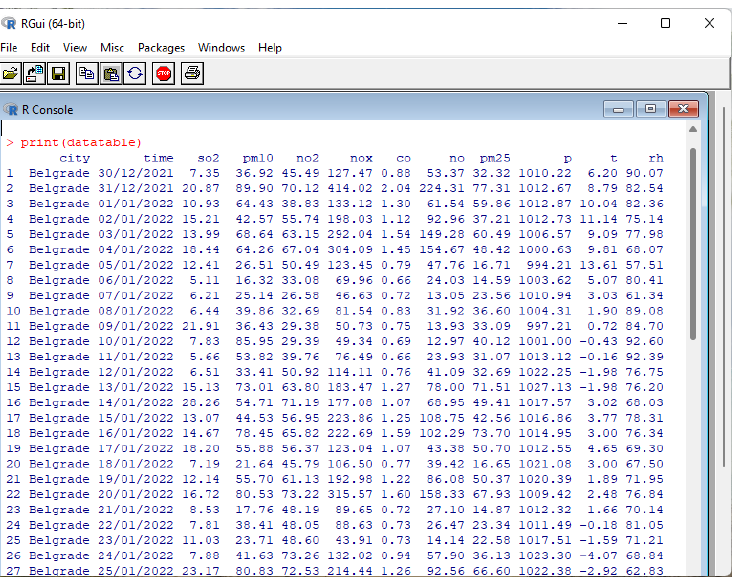
Figure 1. Flowchart presenting the proposed method in an air pollution prediction system, based on the developed R program.